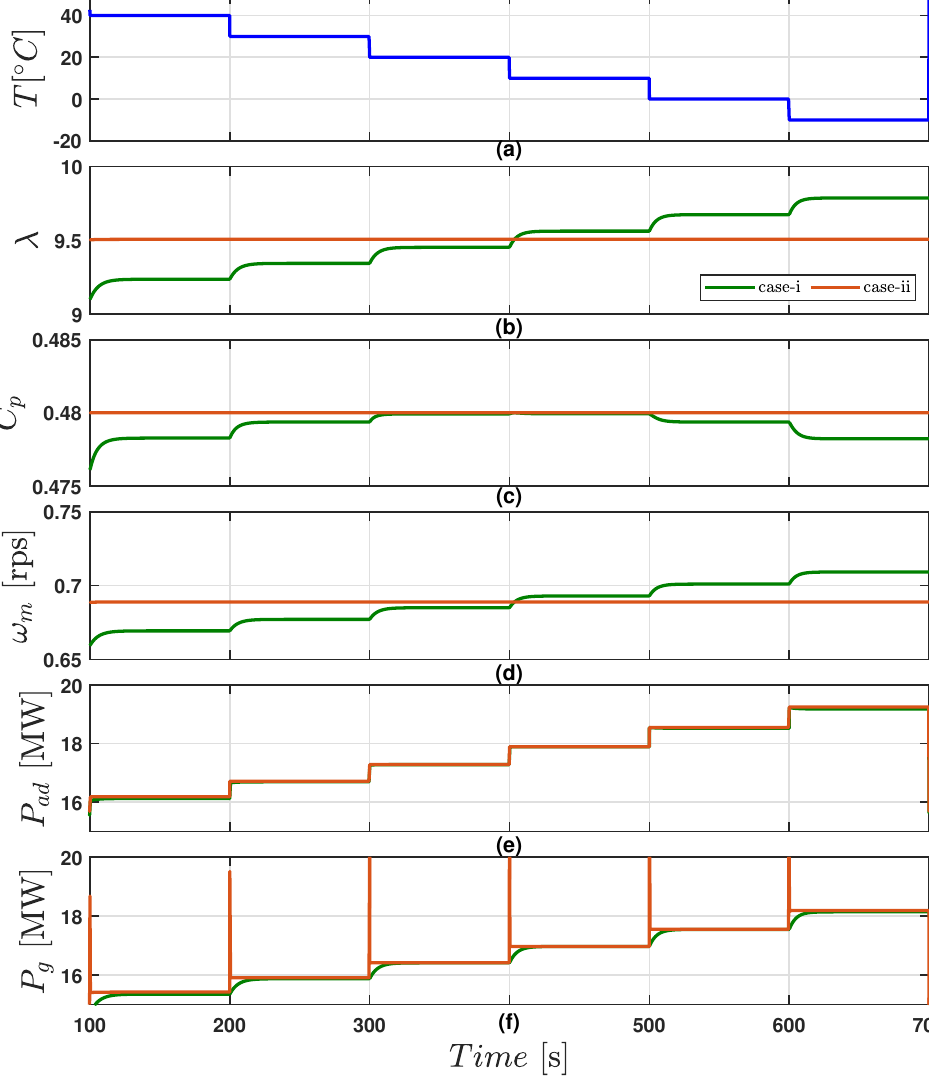
Figure 6. Simulation results of 20 MW WTS under varying temperature conditions. ( a ) Temperature. ( b ) Tip-speed ratio. ( c ) Power coefficient. ( d ) Rotor speed. ( e ) Aerodynamic power. ( f ) Power delivered to the